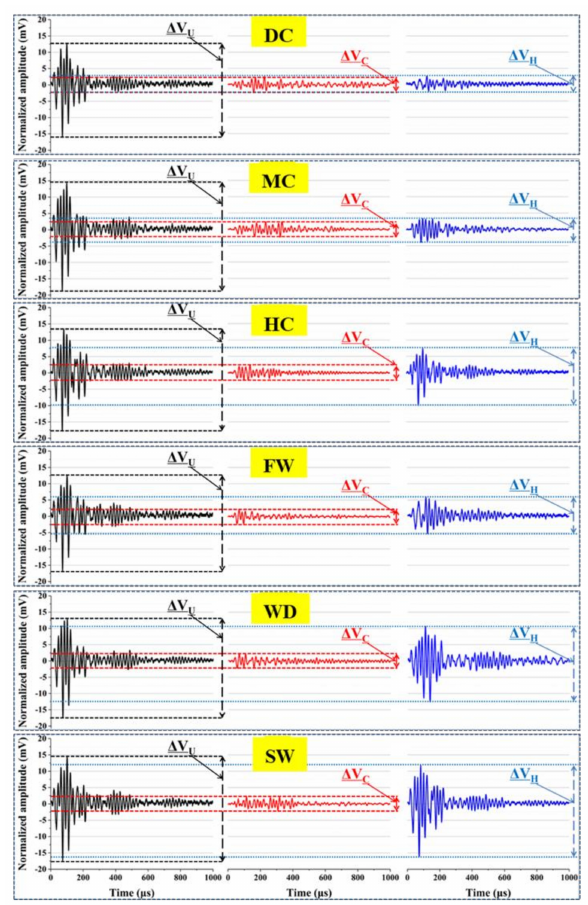
Figure 10. Ultrasonic waveform of samples cured in different conditions.